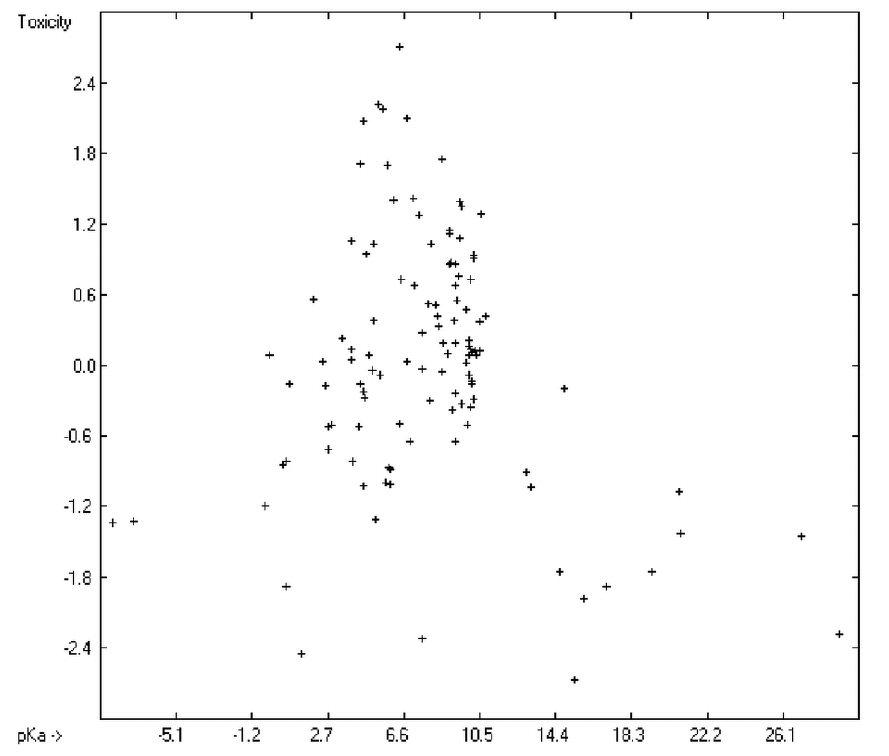
Figure 15. Correlation diagram of logS against toxicity (N = 253, R 2 = 0.6186).